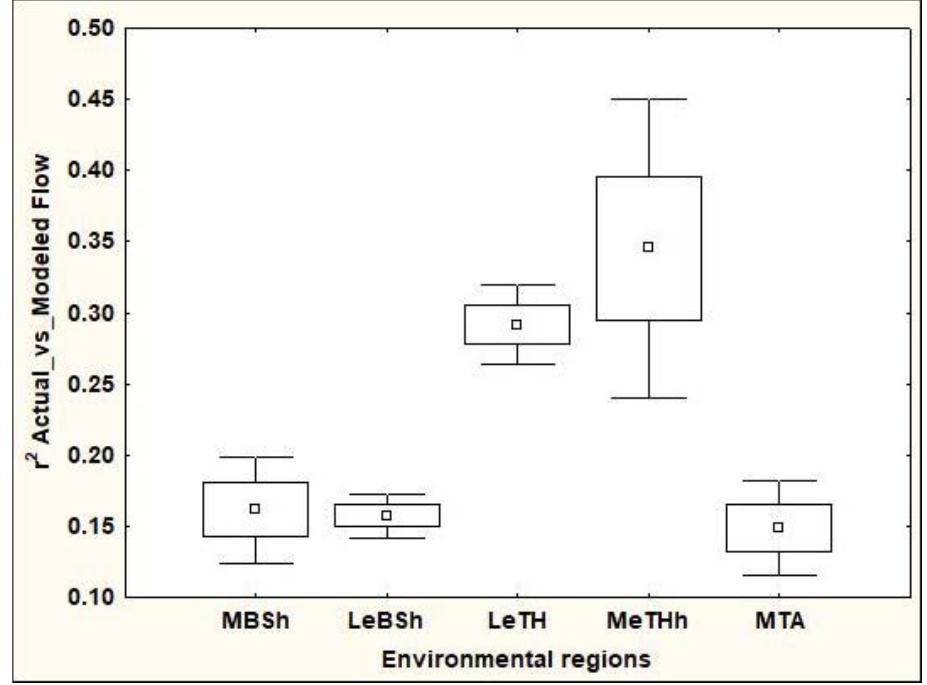
Figure 6. Mean (Inner Square), standard error (bar), 95% confident interval (whisker) of the r 2 values of the correlation between actual and modeled flow in each of the environmental